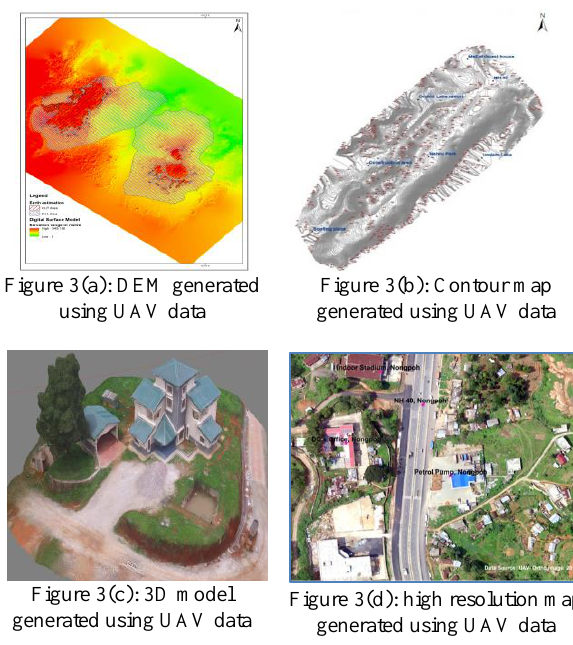
Figure 3: UAV data products generated as part of different applications at